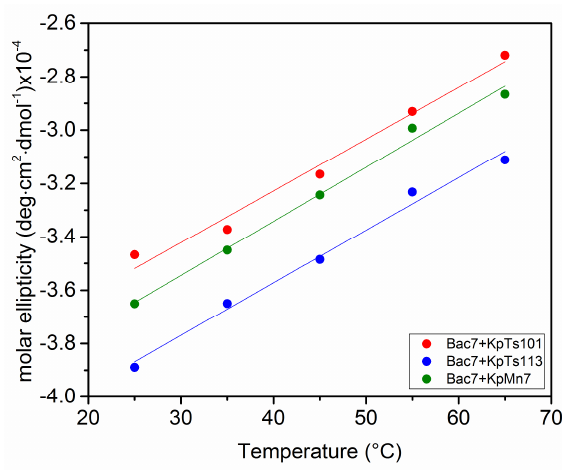
Figure 7. Increasing temperature effect on the Bac7(1–35) conformation in phosphate buffer in the presence of the investigated EPOLs. The CD ellipticity was measured at 205 nm. The EPOL concentrations were KpTs101 = 201 μM; KpTs113 = 198 μM; KpMn7 = 489 μM.